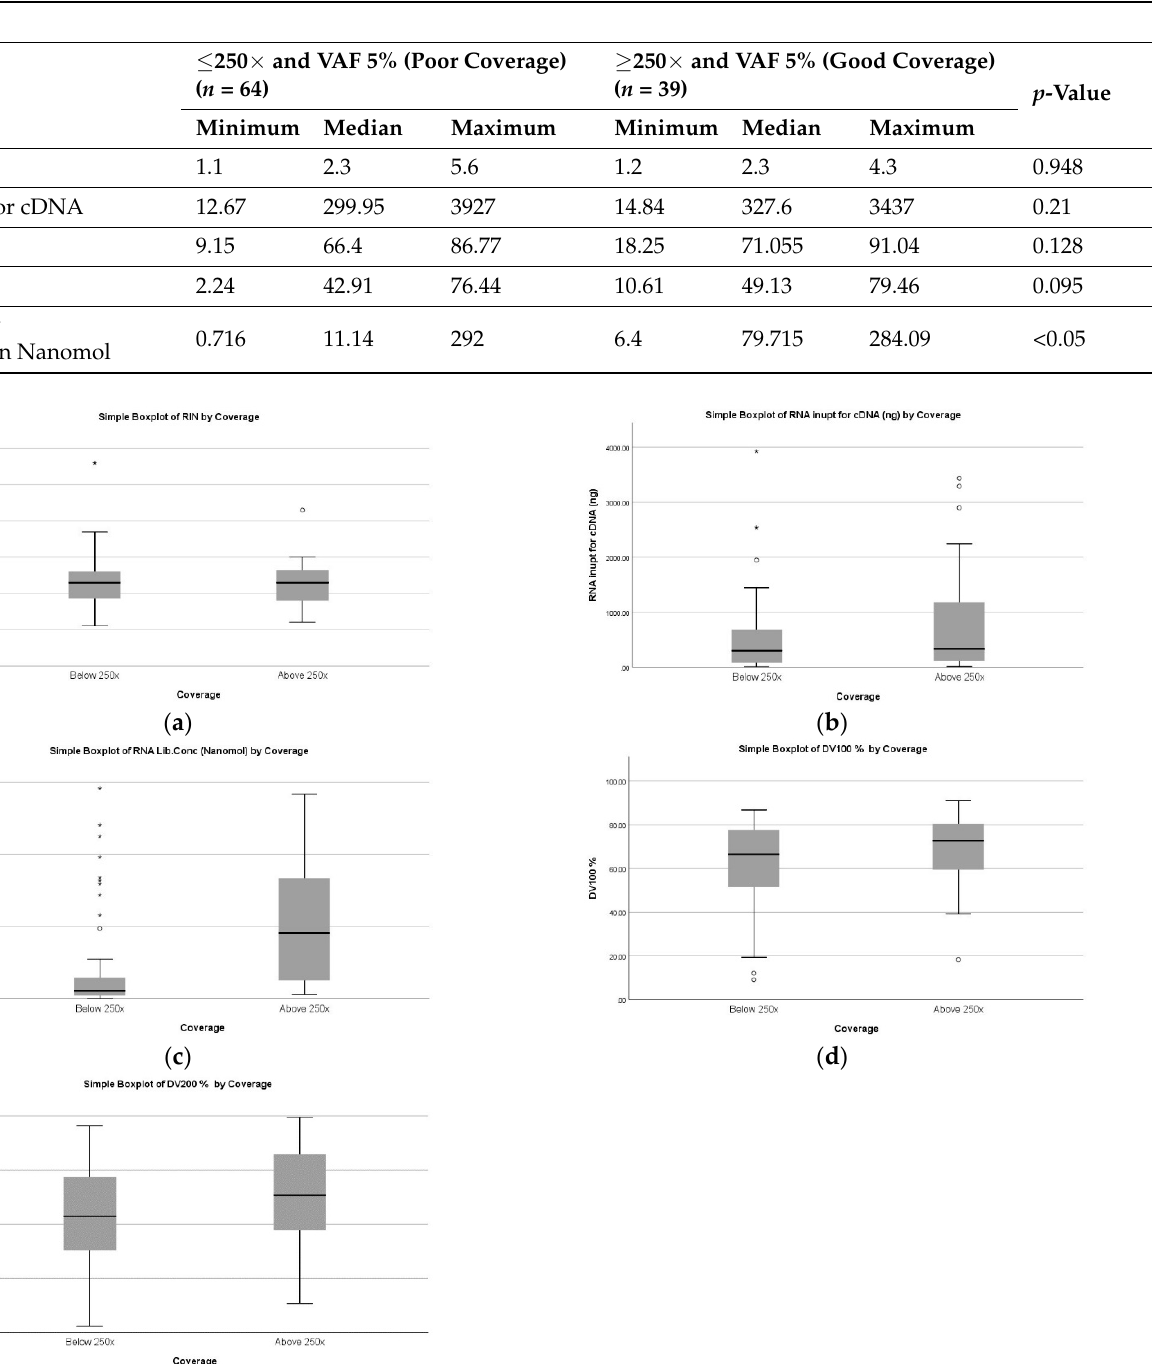
Table 2. Sample characteristics of FFPE RNA according to NGS coverage.